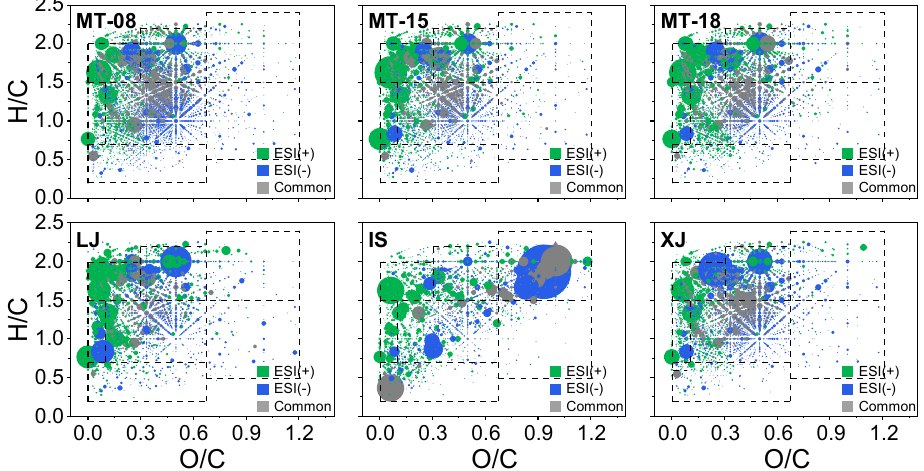
Figure 4. Van Krevelen diagrams demonstrating the compounds identified from different sauce- flavor Baijiu samples. The size of the dots represents the abundance of the assigned molecular for- mulas. The colors represent the unique and common molecular formulas detected by ESI+ and ESI − . The corresponding molecular formulas are listed in detail in the supporting material. Table 2. Number and relative abundance of molecular formulas detected from different samples by ESI+ and ESI − mass spectrometry.